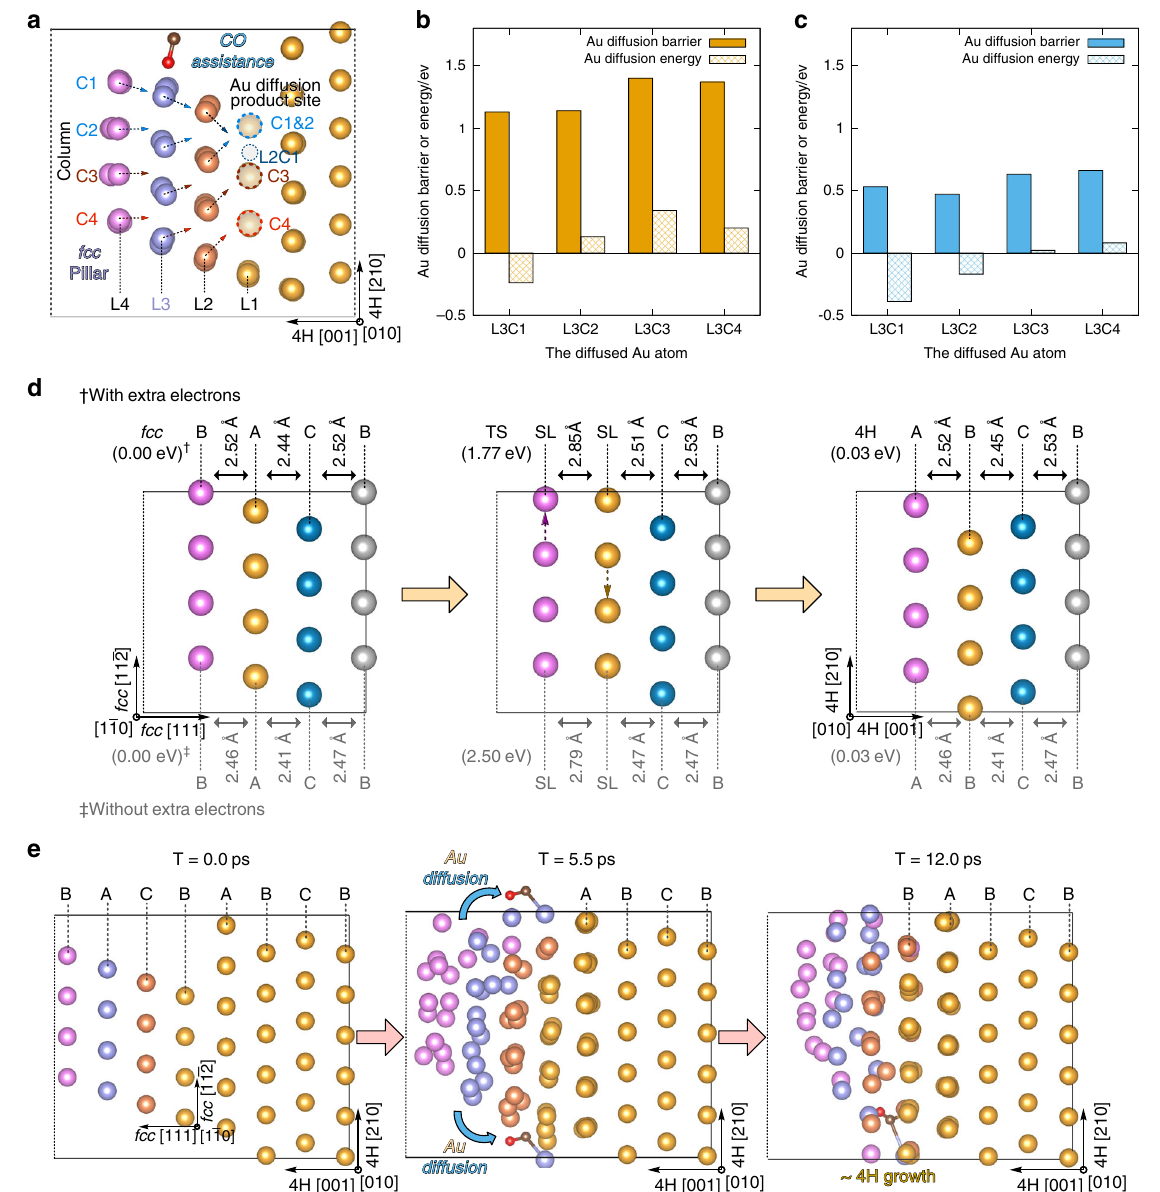
Fig. 5 Theoretical studies on fcc -to-4H transformation. All atoms expect the CO molecule in the fi gure are Au atoms. a Label of the Au diffusion site and the Au diffusion direction from fcc pillars to L1. For brevity the rightest two 4H layers are not shown, and the full atomic model is shown in Supplementary Fig. 1b, c. The active energy and reaction energy of Au diffused from L3, the typical fcc layer, to L1, the 4H substrate: b normal reaction; c reaction with one CO binding on the diffused Au. d Au layer slide assisted by extra electrons. The black numbers are the results calculated with extra electrons, which distribution is shown in Supplementary Fig. 4; the gray numbers are that without extra electrons. e Typical structures in AIMD trajectories with one CO and extra